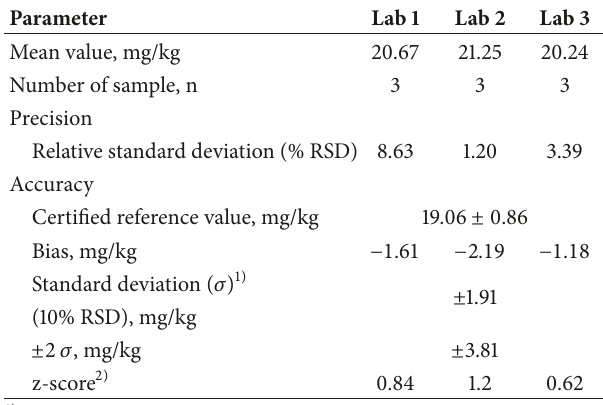
Table 2: Evaluation of precision, accuracy, and z-score between laboratories for